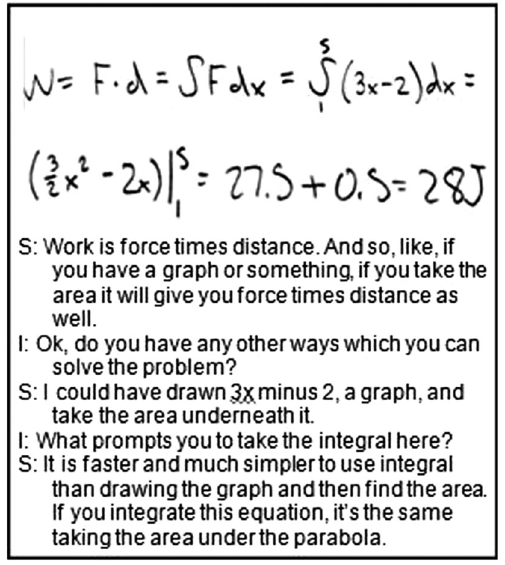
FIG. 21. Solvevaluefromsymbolic representation(question 8).